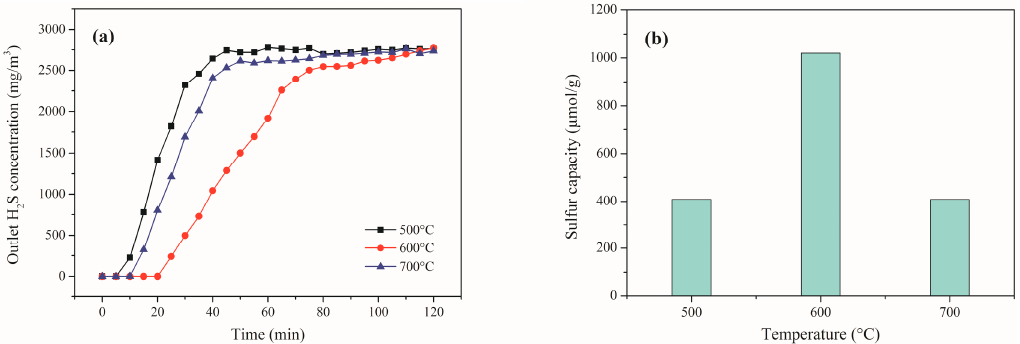
Figure 5. ( a ) H 2 S breakthrough curves and ( b ) sulfur capacities of 5Fe5Ce/ZSM-5 at different